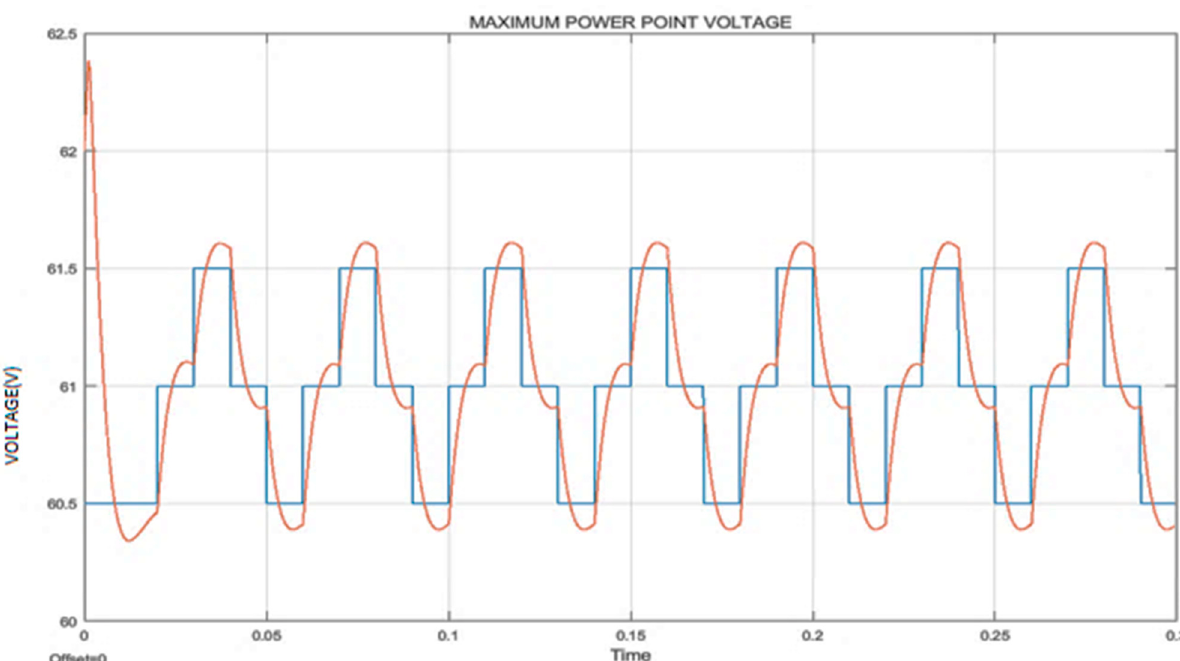
Figure 19. Maximum power-point voltage.